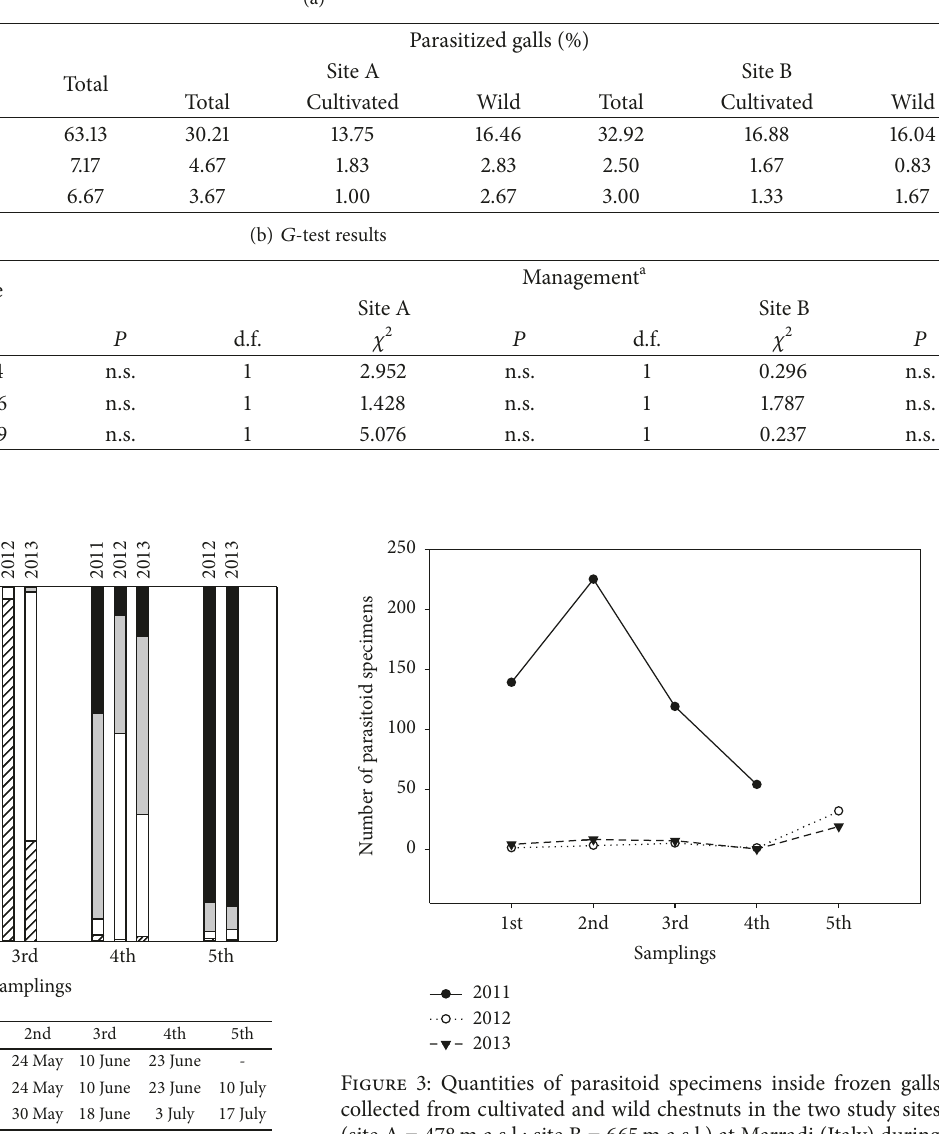
Figure 2: Stages of Dryocosmus kuriphilus specimens inside frozen galls collected from cultivated and wild chestnuts in the two study sites (site A = 478 m a.s.l.; site B = 665 m a.s.l.) at Marradi (Italy) during the three-year period.